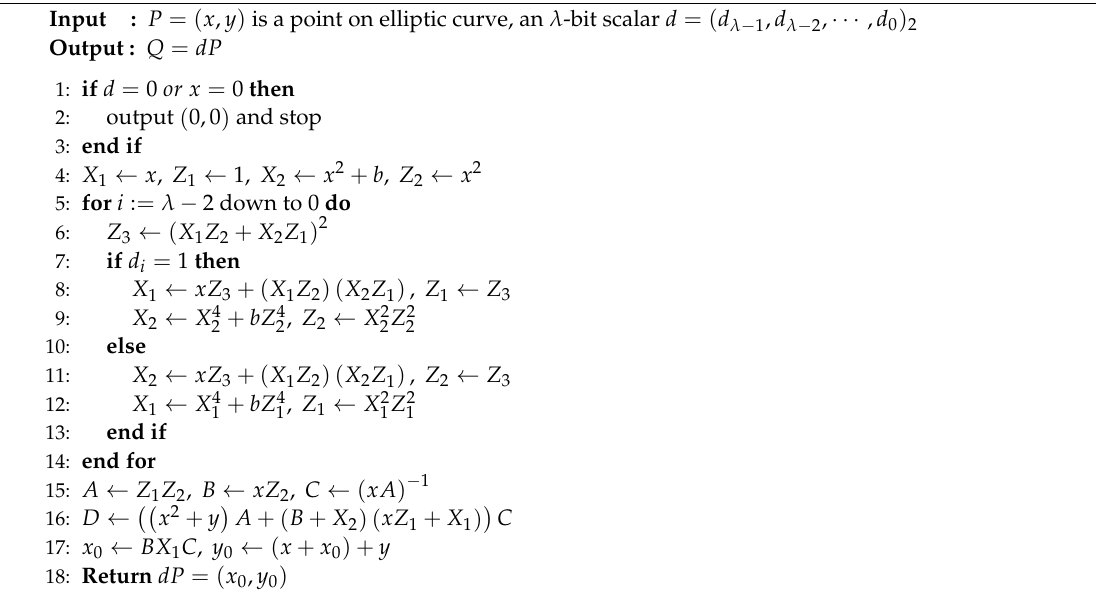
Algorithm A1: Binary scalar multiplication: Montgomery–López–Dahab Ladder